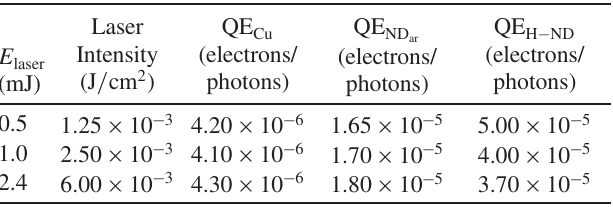
TABLE I. Quantum efficiency (QE) values of the Cu, ND H-ND-based photocathodes at three different values of laser energy ( E ). laser